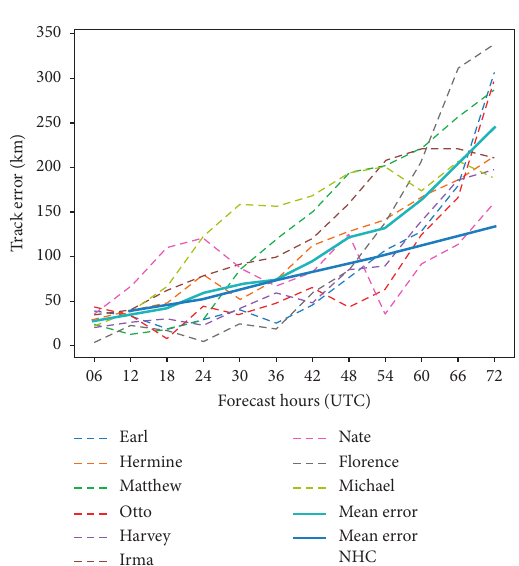
Figure 3: Errors in track forecast. Thick light blue continuous line represents average track error for all TCs investigated in this study. Thick dark blue continuous line represents average track error for the same TCs studied by the NHC, and discontinuous lines rep- resent track forecast error for each TC considered